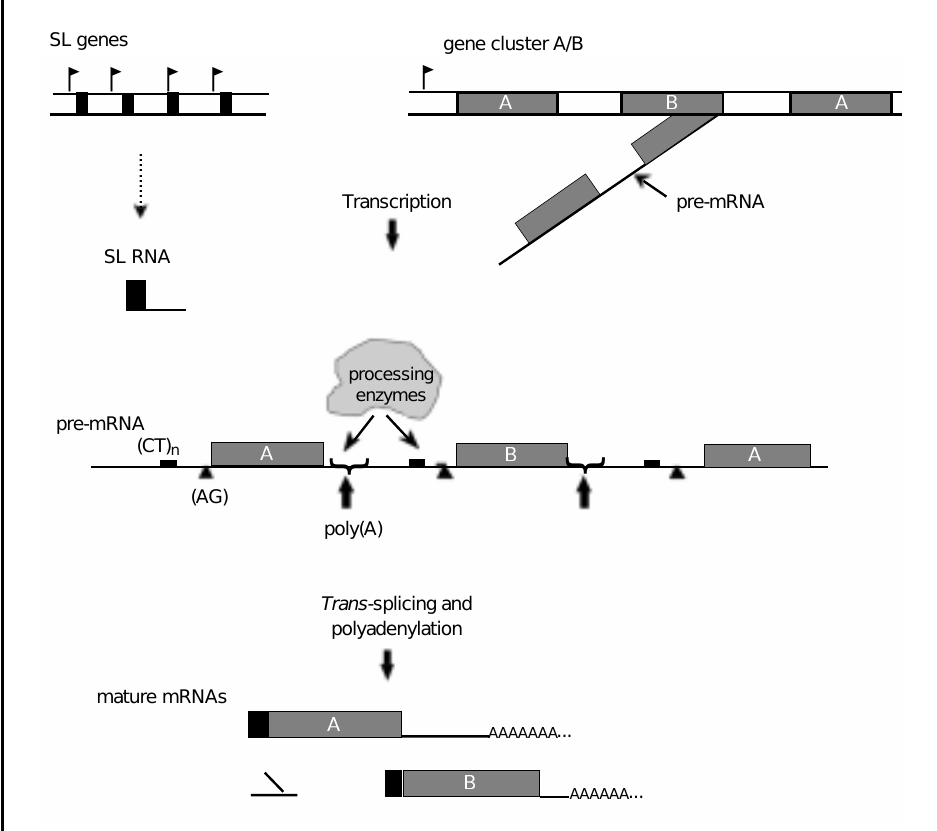
Figure 1 - The general process of mRNA synthesis in trypano- somatids. Most trypanosome and Leishmania genes charac- terized thus far are organized in tandem repeats as indicated by the shaded boxes (representing two copies of an A gene and one copy of a B gene). At an- other chromosomal location there are several hundred tan- dem direct repeats encoding SL RNAs (dark boxes). In some cases, a single promoter is pres- ent upstream of the first gene in the cluster whereas in the SL gene cluster each repeat is pre- sumed to bear a transcriptional promoter (small flags). After transcription, the polycistronic pre-mRNA is processed by trans -splicing and polyadenyla- tion, which require signals pres- ent within the intergenic re- gions: a polypyrimidine-rich se- quence or (CT) n (small boxes), the spliced leader addition site or AG (arrowheads), and a poly- adenylation addition site or poly(A) (arrows). Mature mRNAs which consist of the coding re- gion and 5’UTR (shaded boxes), the SL sequence (dark boxes), 3’UTR and poly(A) tail (thin lines with small “A” letters) are rep- resented by the diagram at the bottom of the